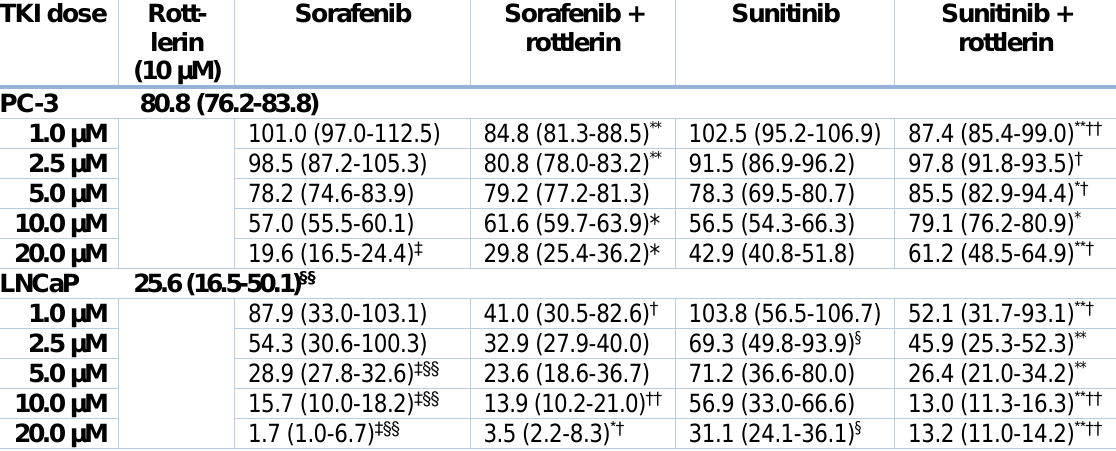
Table 1: Viability of PC-3 and LNCaP prostate cancer cells exposed to various concentrations of soraf- enib and sunitinib with/without rottlerin (10 µM), determined in an MTT assay. The results are presented as medians (interquartile ranges) of the activity in the percentage of unexposed control cells. TKI dose